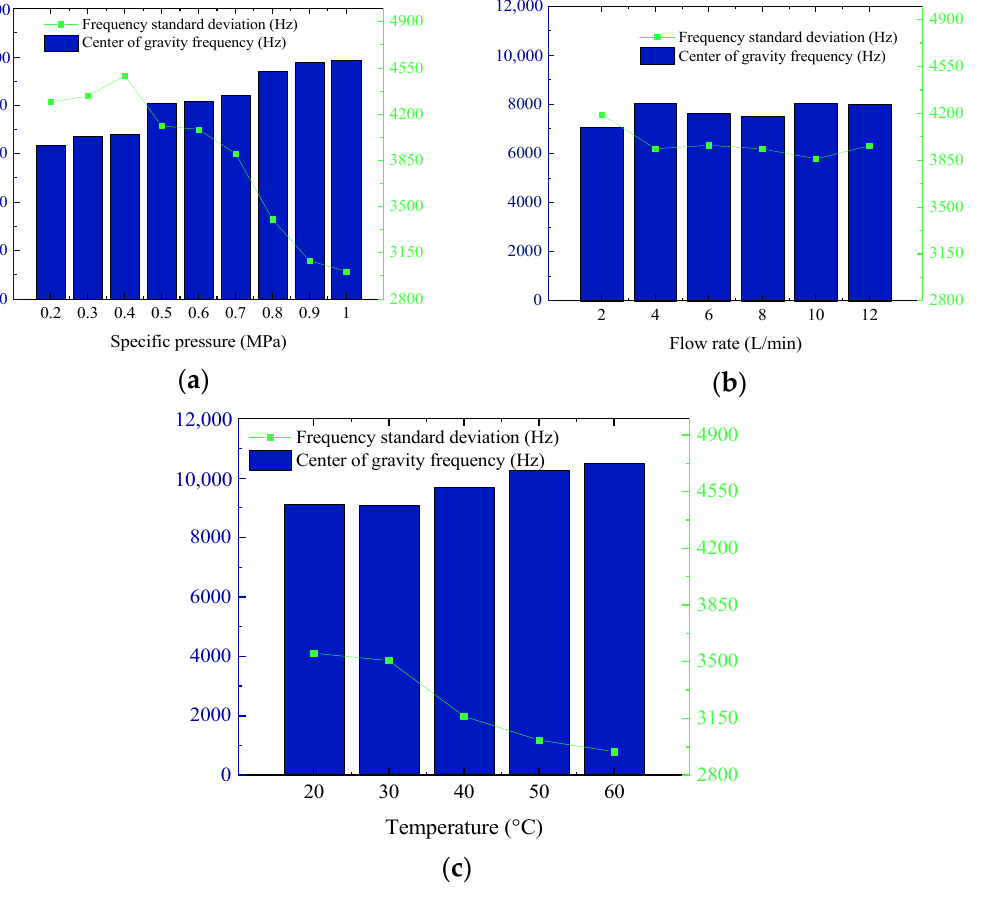
Figure 20. Effect of specific pressure, flow rate, and temperature on frequency eigenvalues. ( a ) Specific pressure, ( b ) flow rate, ( c ) temperature.